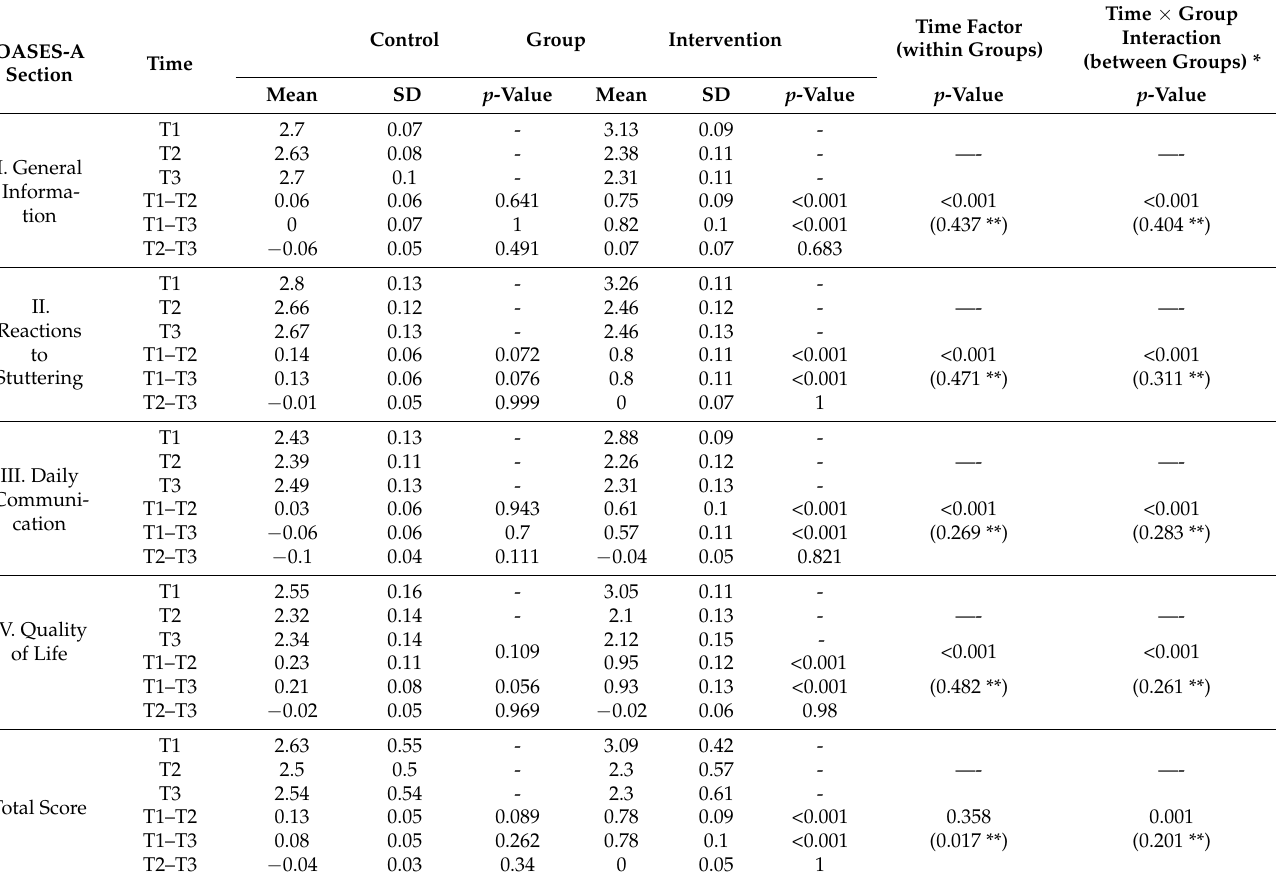
Table 2. Overall Assessment of the Speaker’s Experience of Stuttering-Adults—comparing IBSR intervention with the control group.